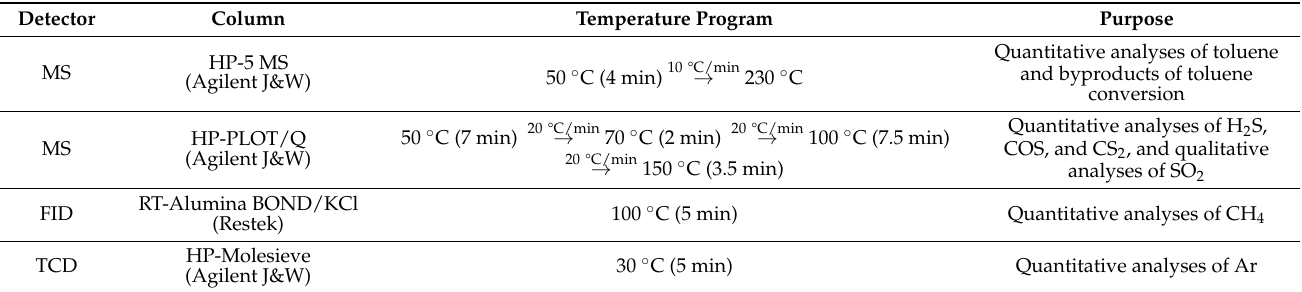
Table 1. GC methods applied in the